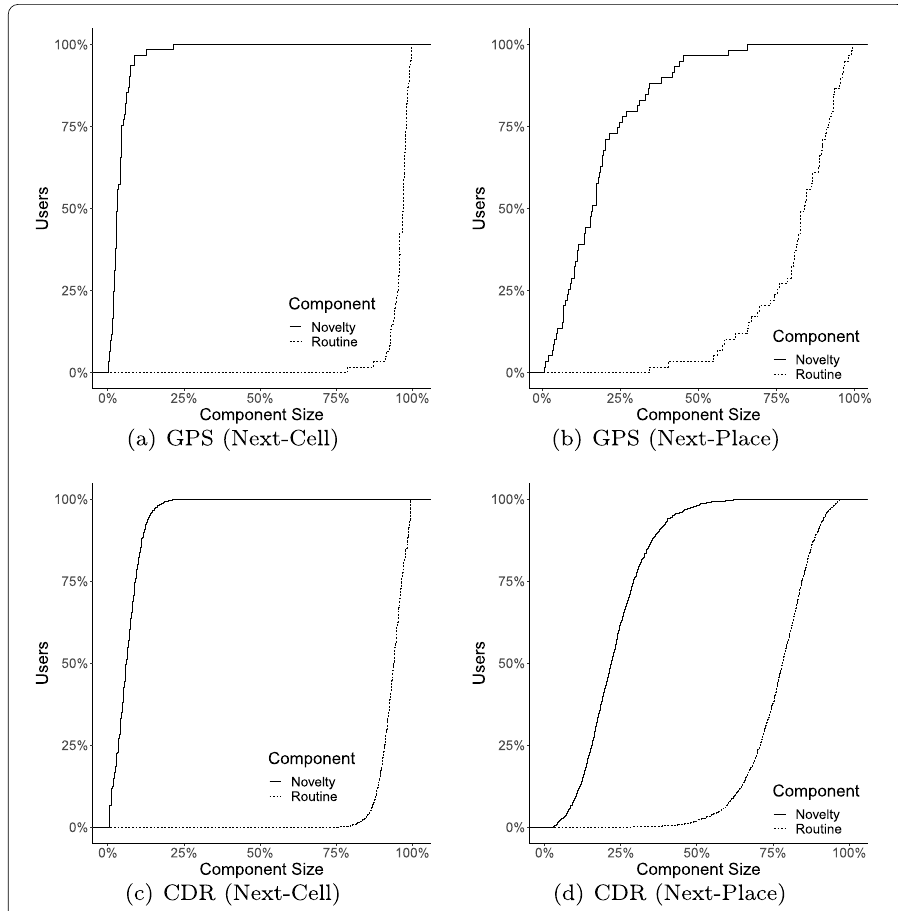
Figure 4 Cumulative distributions of the size of the routine and novelty components in our two datasets